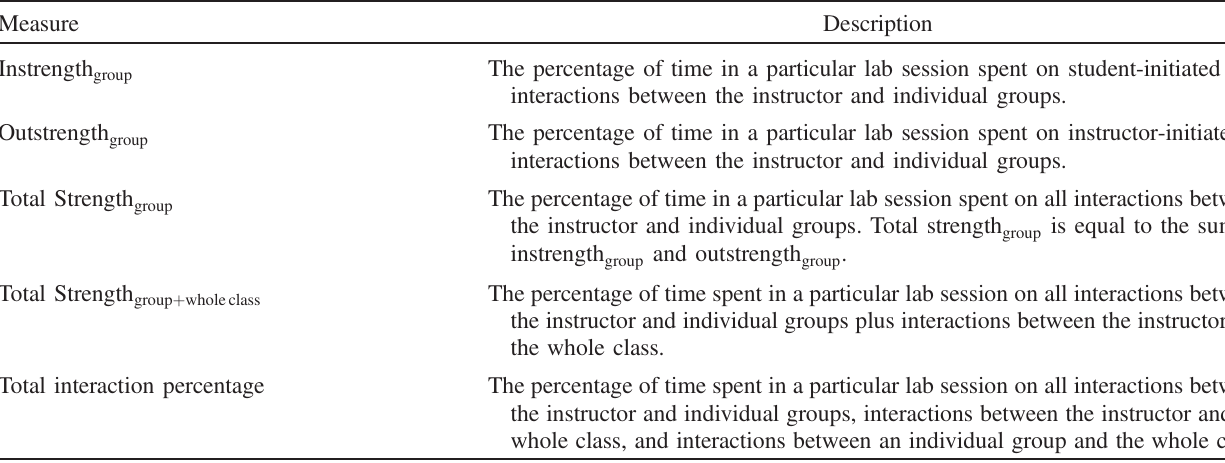
TABLE III. Summary of all measures used to evaluate